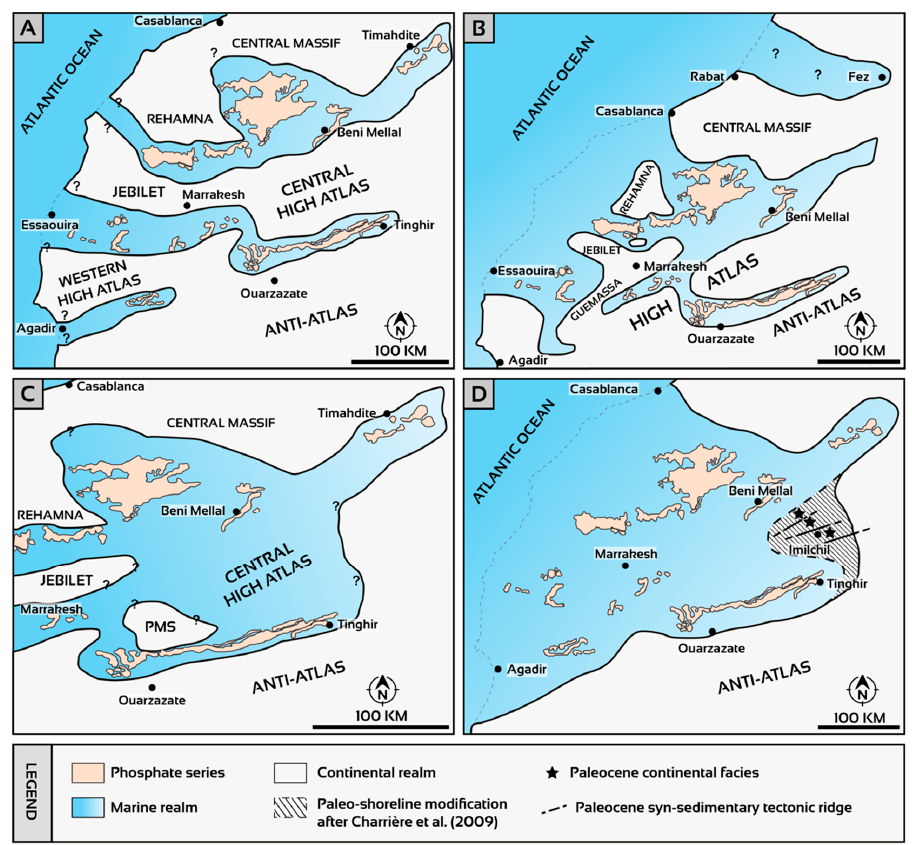
Figure 8. Paleogeographic models of the Moroccan phosphogenic system: ( A ) Model of several narrow gulfs [89]. ( B ) Large Atlantic Ocean connection with interconnected gulfs [104]. ( C ) Model of a single epicontinental sea with the presence of land masses [105,106]; PMS: Paleozoic Massif of Skoura. ( D ) A single epicontinental sea without land masses [91].